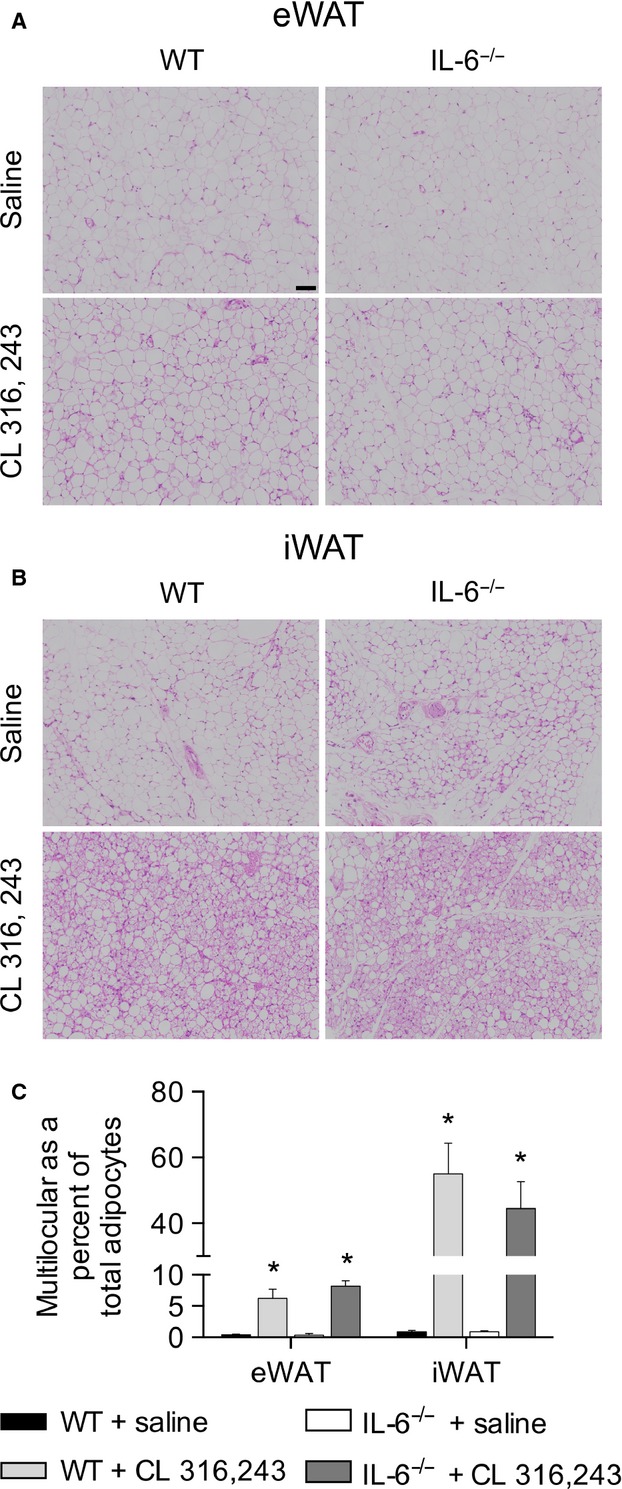
Treatment with CL 316,243 increases the appearance of multilocular fat cells in epididymal (A) and inguinal (B) adipose tissue from WT and IL-6−/− mice. Adipose tissue sections were stained with hematoxylin and eosin and imaged under 40× magnification. Approximately 500 cells per animal was analyzed and the ratio of multilocular to total adipocytes was calculated for eWAT (C) and (D) iWAT. The black scale bar is 71 μm.